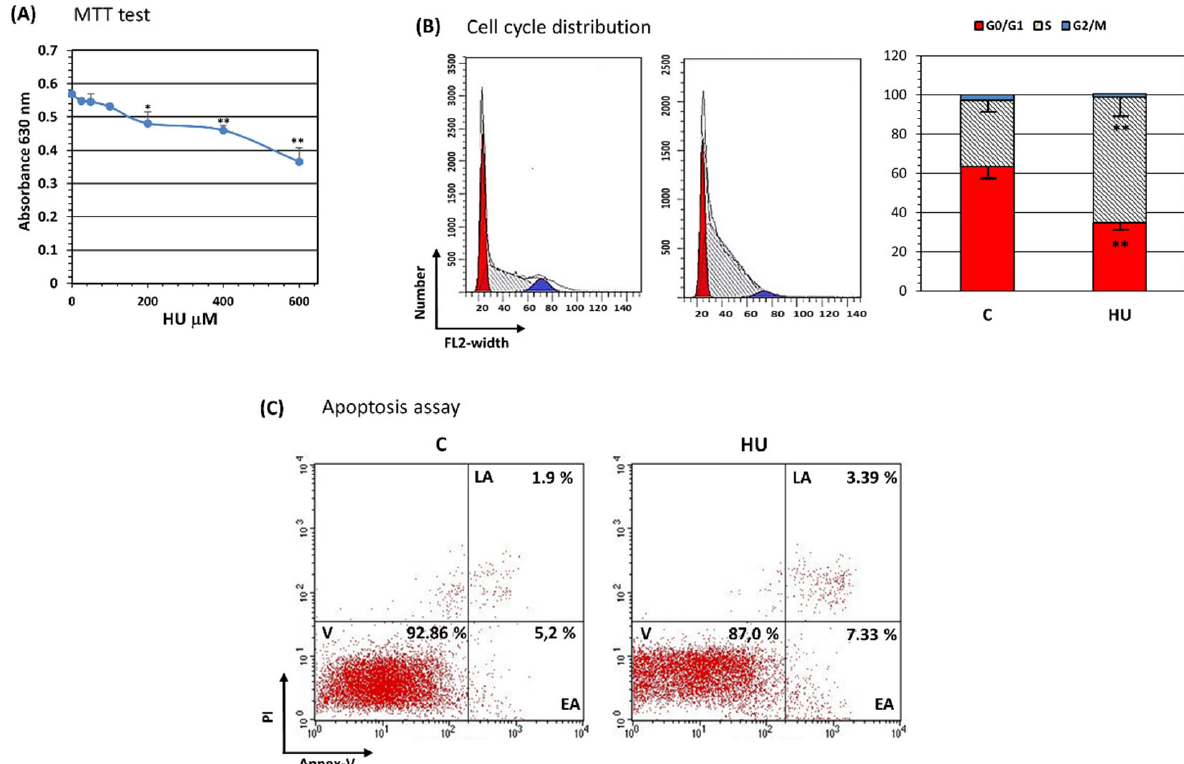
Figure 2. Hydroxyurea inhibits BMMSC proliferation without reducing cell viability. BMMSC were treated for three days with HU and ( A ) proliferation determined by MTT assay. ( B ) Cell cycle analysis was performed by flow cytometry. Results indicated that HU provoked a cell cycle arrest at S phase. ( C ) viability/apoptosis analysis was performed. No differences were obtained compared with control cells. PI, propidium iodide; Annex-V, annexin-V; V, Viable cells; EP, early apoptosis; LP, late apoptosis. Results presented are representative from at least 3 performed experiments. Significant difference control cells by t -test: p < 0.05 (*) and p < 0.005 (**).